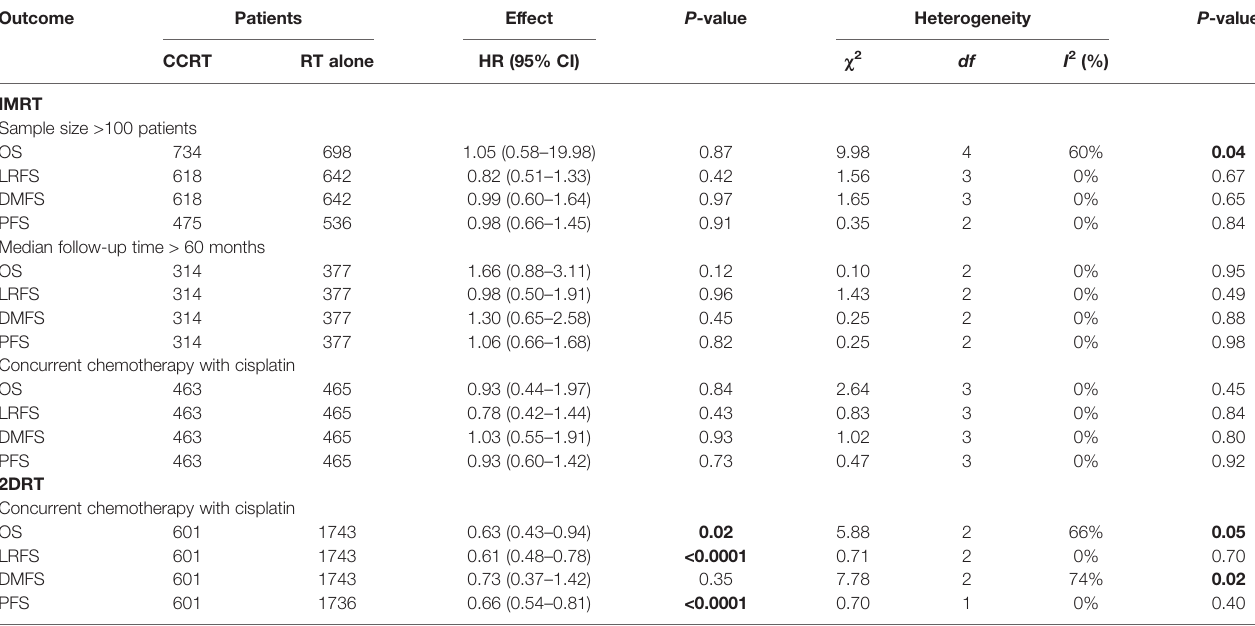
TABLE 3 | Sensitivity analysis for the comparison of CCRT and RT alone.